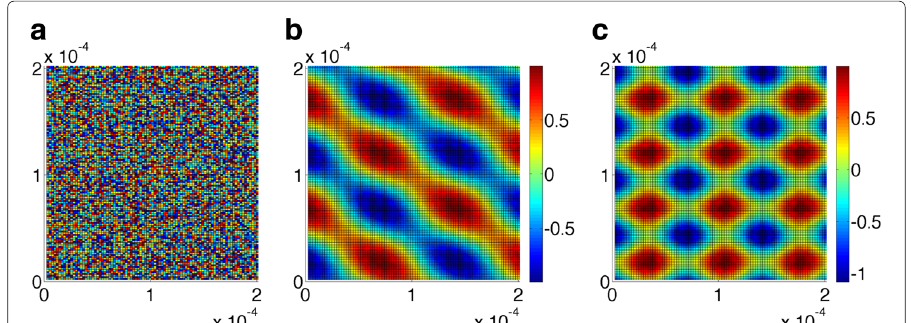
Fig. 12 Height data for the surface profiles of the ( a ) original surface prior to evolution, and surface after 60 h of evolution using ( b ) the linear evolution equation and ( c ) nonlinear evolution equation at θ = 50°. The surface height is normalized to the maximum height, where the peaks are shown by the red regions while the troughs are shown as blue . The x - and y-axes are expressed in [m] to show the feature size. The evolution parameters are as shown in Table